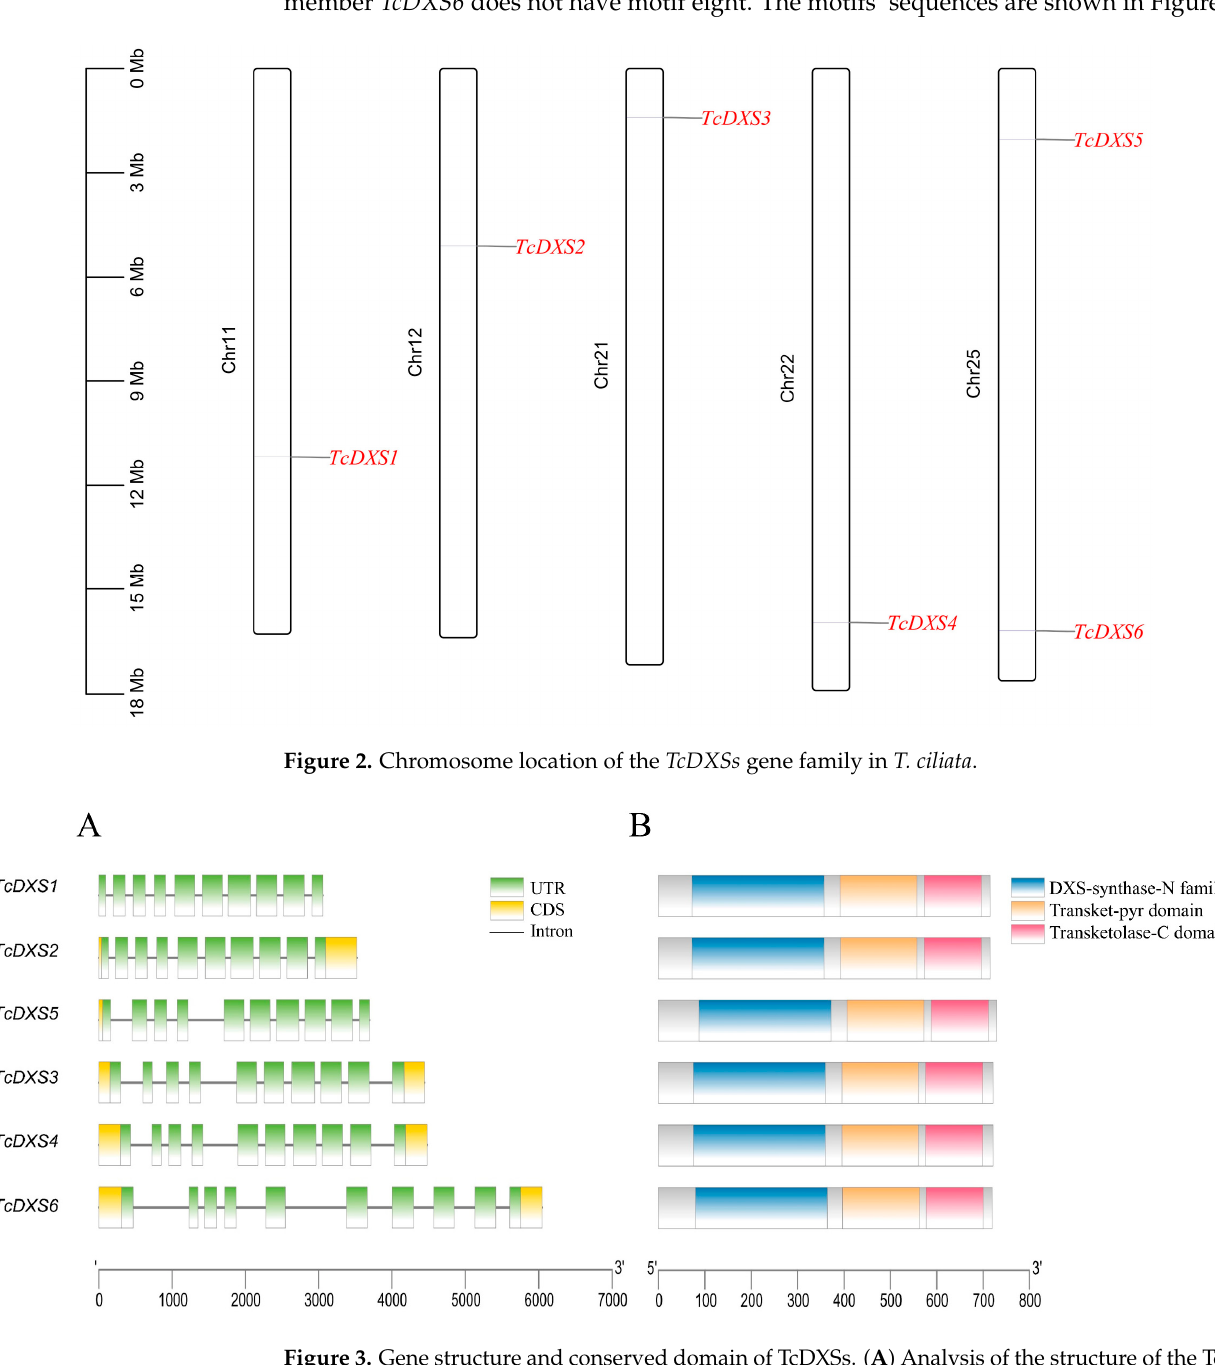
Figure 3. Gene structure and conserved domain of TcDXSs. ( A ) Analysis of the structure of the TcDXS genes. The green and yellow boxes represent UTRs and CDSs, respectively; black lines represent introns. ( B ) Analysis of the conserved domain of the TcDXS proteins. Green boxes indicate the DXS-synthase-N family, yellow boxes indicate the Transket-pyr domain and pink boxes indicate the Transketolase-C domain.